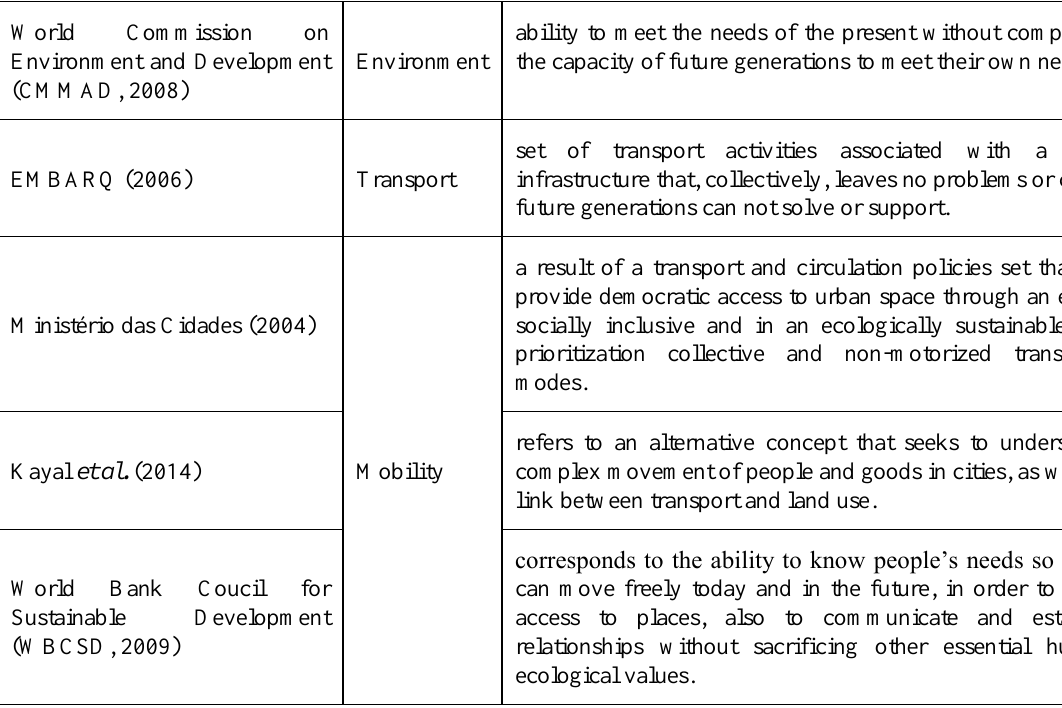
Table 1.Relation between sustainability, environment, transports and mobility. Source: